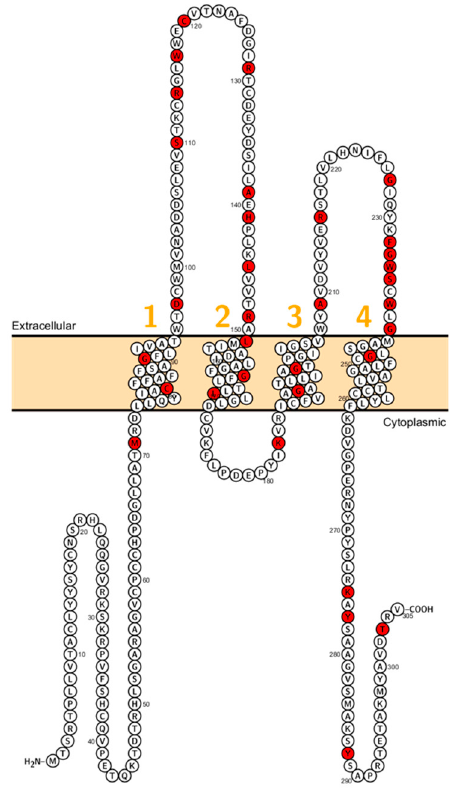
Figure 6. Topology of CLDN16. FASTA sequence of CLDN16 (Uniprot accession no: Q9Y517). Each amino acid is shown as a single letter code and numbers (orange) indicate transmembrane domains. Mutations shown to be involved in human diseases are shown in red.